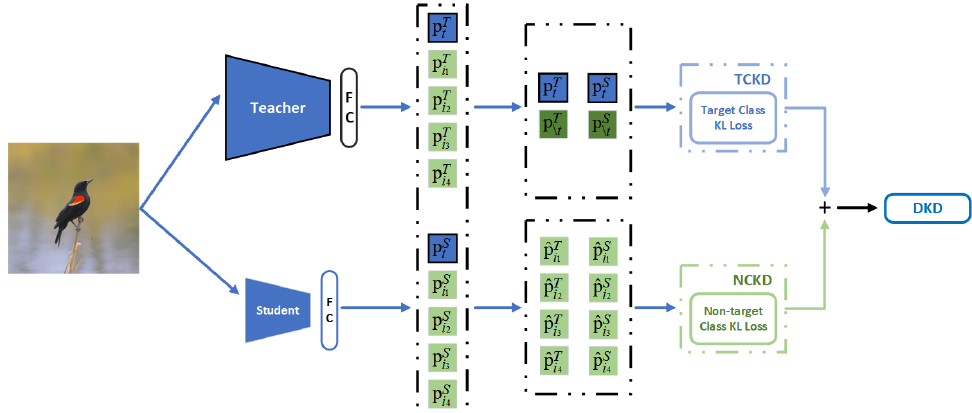
Figure 5. The method of decoupled logit distillation. We decouple the logit distillation by using logit distillation separately for the target and nontarget